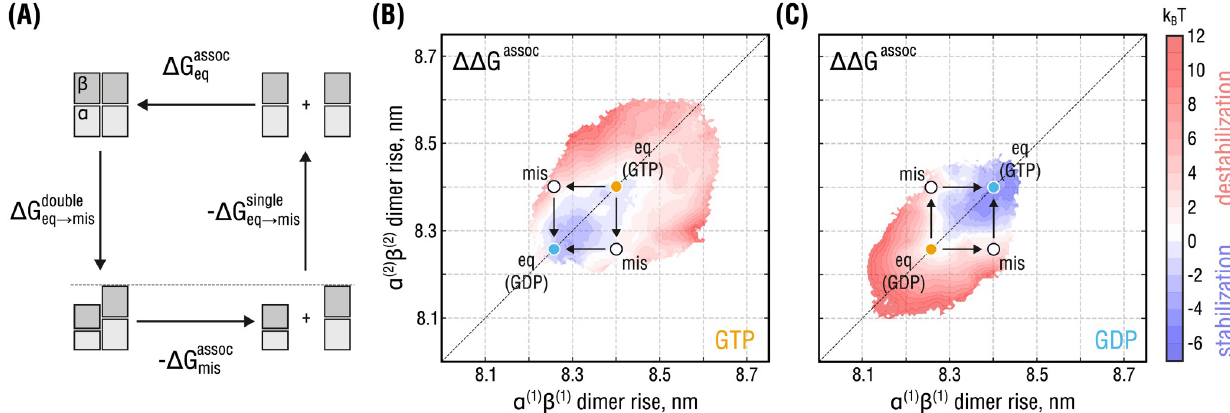
Fig 4. Relative thermodynamic stability of the lateral bond in the double-PF system. (A) , Thermodynamic cycle demonstrating the idea behind estimating the effect of unequal PF conformations on the association free energy between the PFs. While simulating the horizontal transitions (PF association) is computationally more expensive, the free energy changes linked to the vertical transitions (PF compaction) have already been obtained (Figs 2 and 3). (B) and (C) , Distributions of the relative stability of the double-PF systems with respect to their equilibrium conformations marked with orange and cyan circles for GTP- and GDP-state, respectively, as a function of dimer rise and nucleotide state. White circles denote conformations with the strongest observed dimer rise mismatch. Free energy color coding is adjusted such that red (blue) areas correspond to conformations of the double-PF system in which the lateral bond is destabilized (stabilized) relative to equilibrium. White areas correspond to no change in the lateral bond stability.